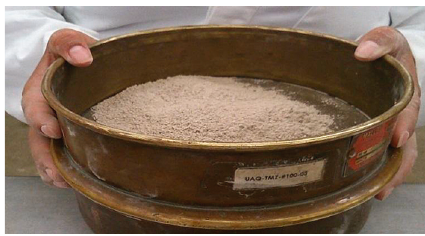
Figure 3: Sample of recycled Quarry (own source).